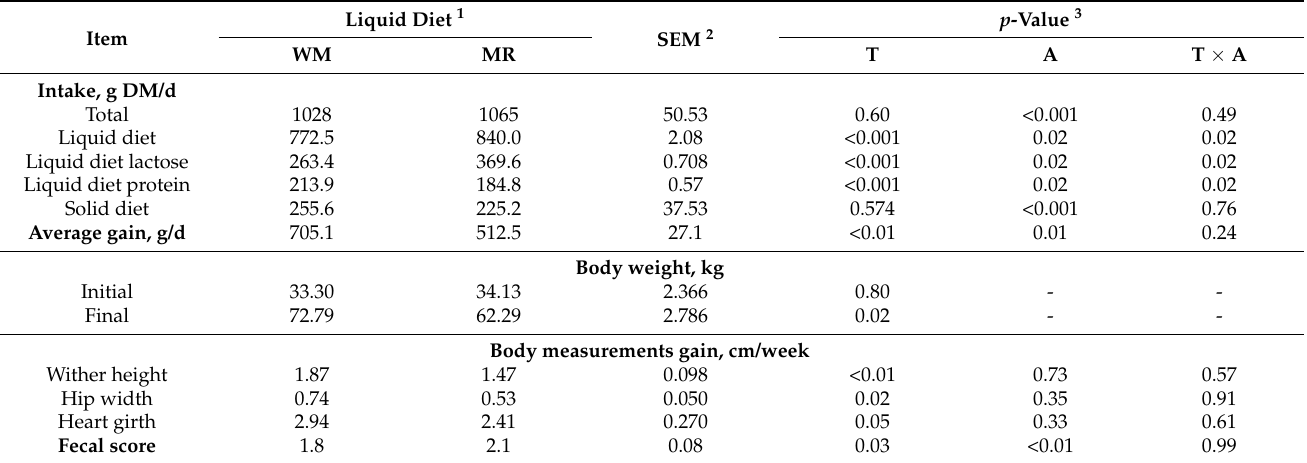
Figure 2. Fecal scores according to the age of calves fed whole milk (WM) or milk replacer (MR) as liquid diet.